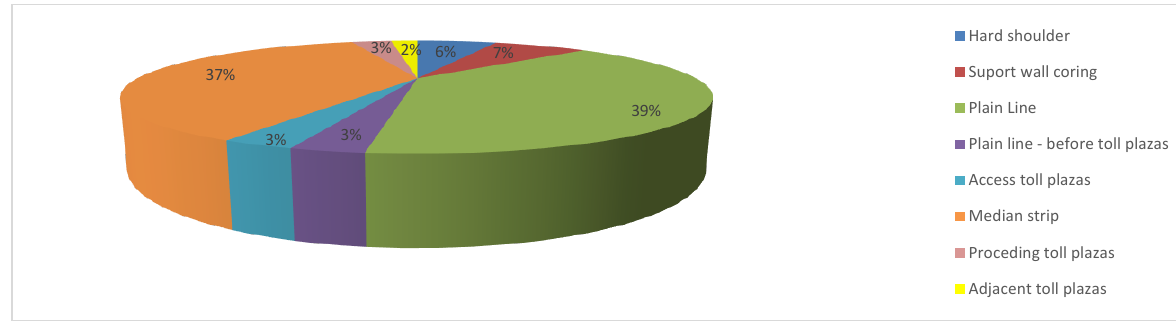
Figure 3. Location of risks